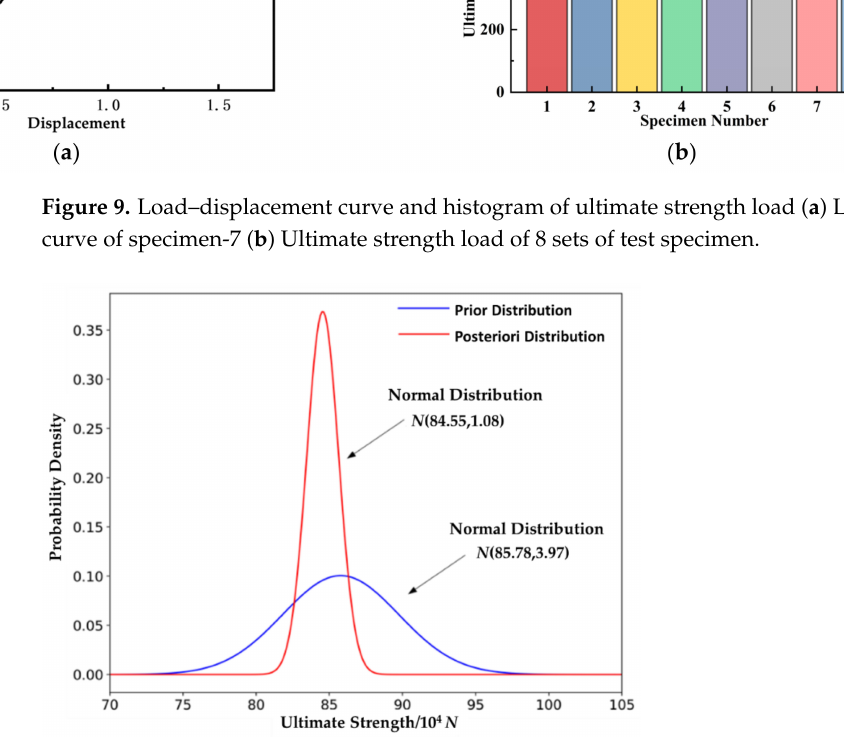
Figure 10. Probability density distribution plot before and after Bayesian